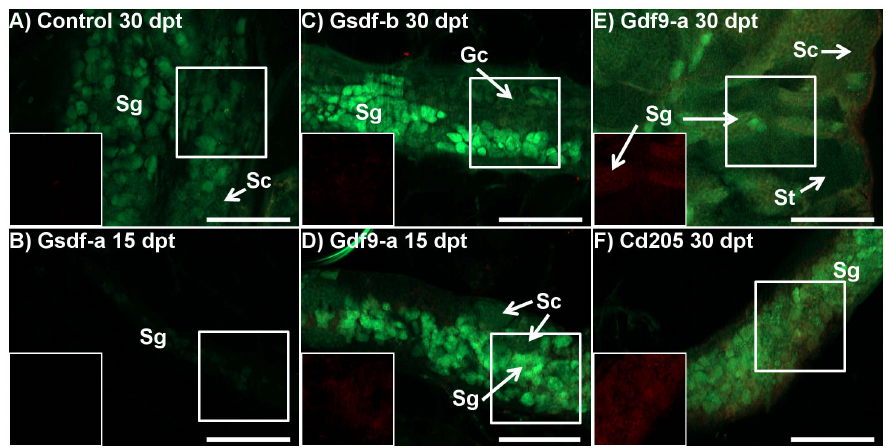
Figure 7. Immunohistochemistry of Bcl2-interacting-killer (Bik) protein in testes of control and treated zebrafish of the tg ( vas::egfp ) line. Merged images combine the eGFP filter (green; germ cell lineage), and dsRed filter (red; Bik protein) under epifluorescent light. A) Control fish 30 days post treatment (dpt) (D; 59.3 mg, 21.3 mm): only a few small points of Bik signal were detected. The cell lineage from which the signal originates could not be determined. The testes were developing normally with clusters of spermatogonia (sg) and spermatocytes (sc) visible. B) Anti-Gsdf-a treated fish 15 dpt (27.3 mg, 16.0 mm): The testis was extremely early in development with only a few spermatogonia expressing weak eGFP signal. No Bik signal was detected. C) Anti-Gsdf-b treated fish 30 dpt (86.4 mg, 23.4 mm): Only a very weak Bik signal is detected in the testes. Only presumptive spermatogonia (sg) and undifferentiated gonocytes (gc) were identified. D and E) Anti-Gdf9-a treated fish at 15 and 30 dpt, respectively (D: 46.2 mg, 20.3 mm, E: 138.7 mg, 26.5 mm): Bik signal was localized to clusters of spermatogonia. In contrast, the clusters of spermatocytes (sc) and spermatids (st) did not show Bik signal. F) Anti-CD205 treated fish at 30 dpt (128.4 mg, 25.1 mm): a strong Bik signal was detected throughout the testis. However, resolution was insufficient to determine from which cell types it originated. All scalebars represent 100 m m. White boxes identify area being shown with dsRed filter